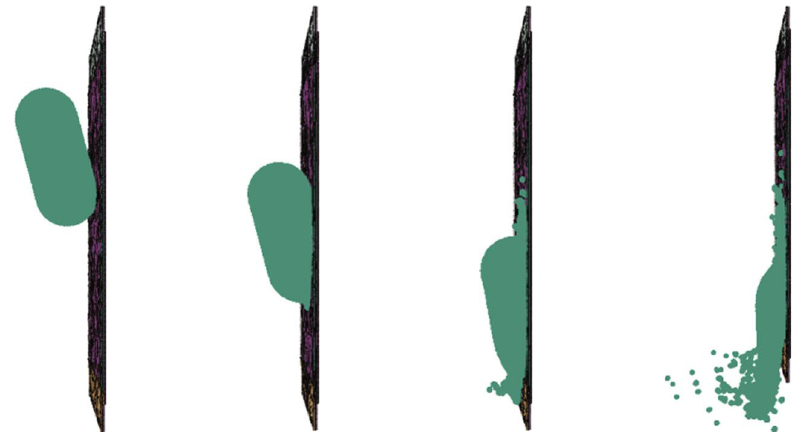
Figure 16: Morphology of the bird body at di ff erent moments of 15 ° .